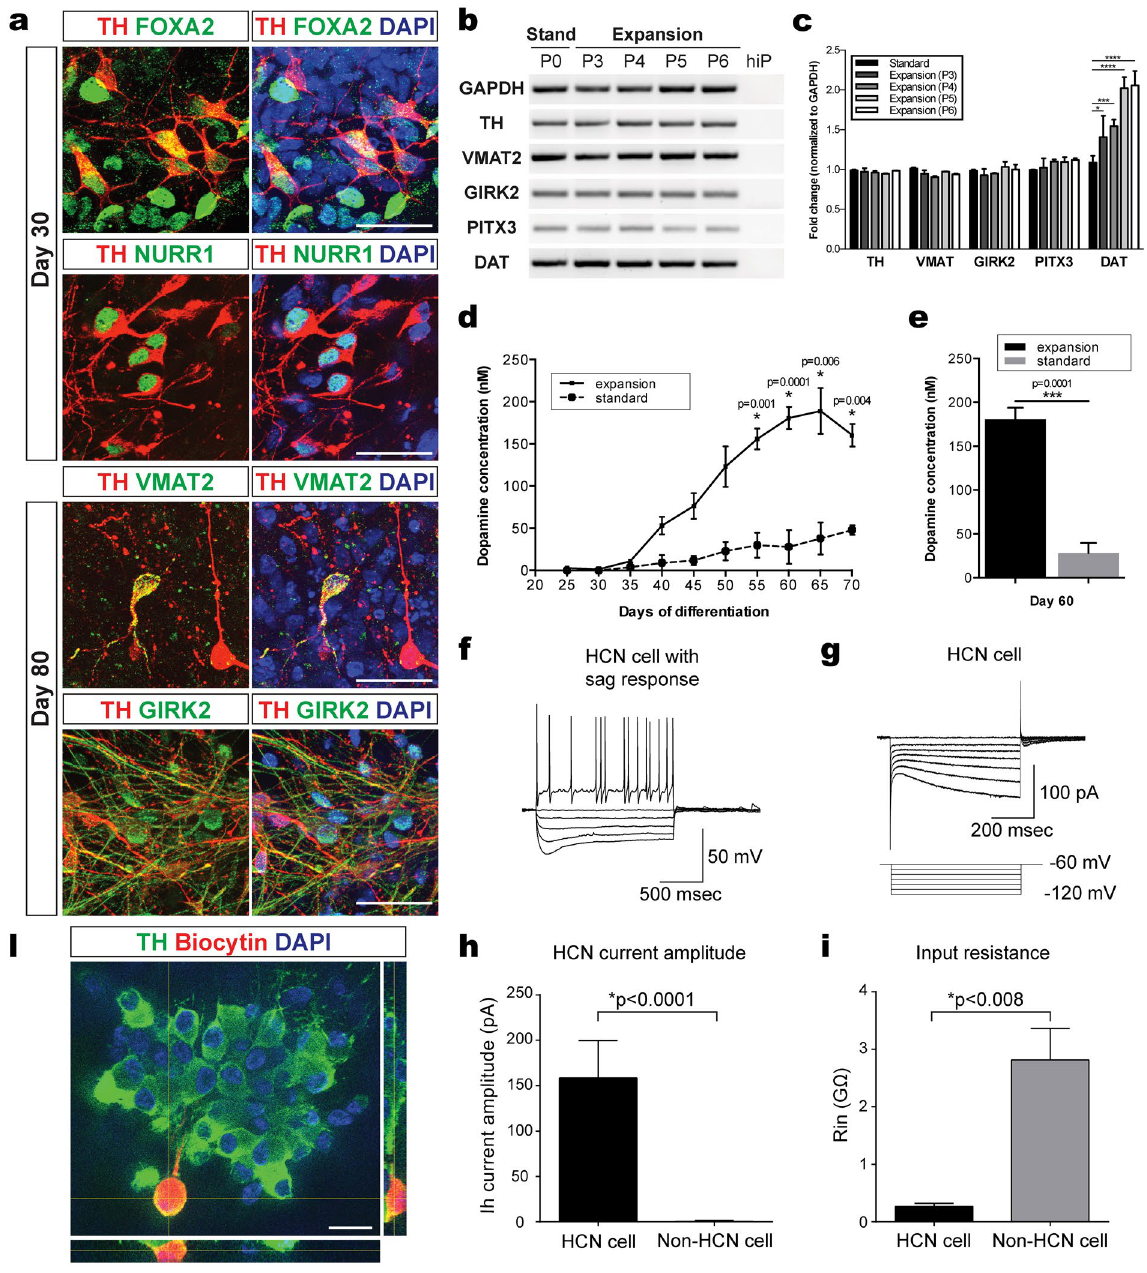
Figure 5. hiPSC-derived expanded mFPPs maintain their capability to differentiate into mature and functional DA neurons in vitro . ( a ) Immunocytochemical analysis of expanded progenitor-derived DA neurons showed the expression of mature DA neuron specific markers, such as FOXA2, NURR1, VMAT2 and GIRK2. ( b ) RT-PCR analysis revealed the expression of mature DA neuron-specific markers, such as TH, VMAT2, GIRK2, PITX3 and DAT, in DA neuron cultures after different passages of expanded progenitors (P3–P6). The image contains cropped gel images showing the respective amplicons. Images of the full gels are shown in supplemental data Figure S4 ( c ) Quantitative gene expression analysis of mature DA neuron-specific markers, TH, VMAT2, GIRK2, PITX3 and DAT, showed no different between the standard and expansion protocols. However, DAT mRNA levels were found upregulated after progenitor expansion, suggesting a higher level of maturation in expanded progenitor-derived DA neuron cultures compared to the standard procedure. ANOVA test. Mean ± S.E.M. (n = 3). ( d ) Dopamine measurement by liquid chromatography-mass spectrometry (LC- MS) in medium collected over time from DA neuron cultures generated by using either the standard or the expansion protocol. The analysis showed higher dopamine concentrations in expanded progenitor-derived DA neuron cultures compared to the standard cultures. Student’s t-test. Mean ± S.E.M. (n = 3–5). ( e ) Example of dopamine levels measured in cell cultures derived from the standard (28 ± 20 nM) and the expansion methods (180.59 ± 34.94 nM) at day 60 and day 60 + EXP , respectively. Student’s t-test. Mean ± S.E.M. (n = 3–7). ( f ) Representative current-clamp example traces of an HCN-positive cell showing voltage sag response